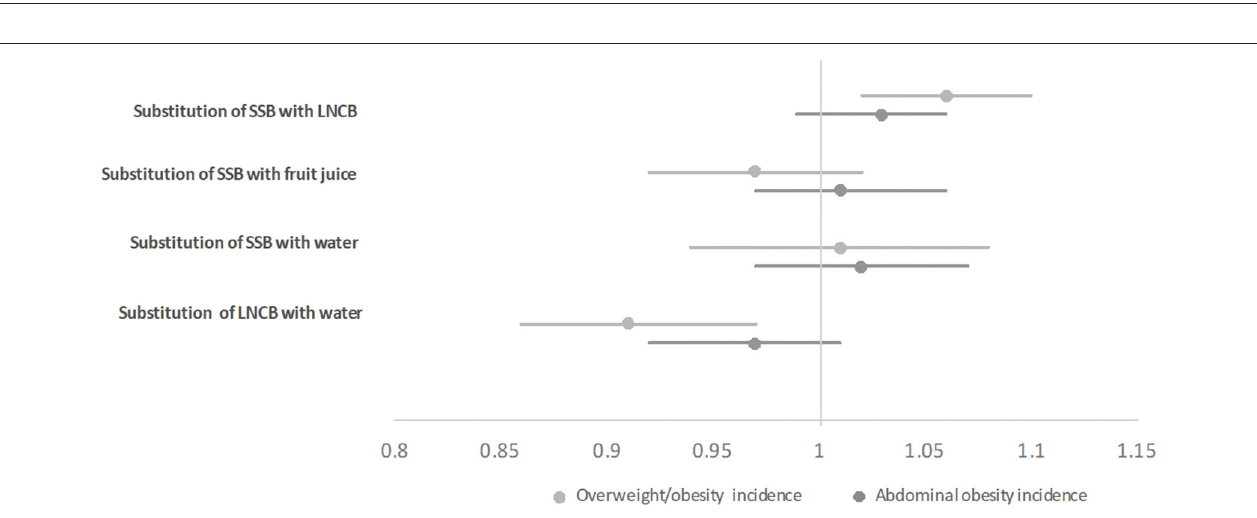
FIGURE 4 | Adjusted substitution associations of one serving of beverage with another with overweight/obesity incidence (IPR, 95%CI) and abdominal obesity incidence (IPR, 95%CI) in participants with normal values at baseline (i.e., < 25 kg/m 2 for overweight/obesity and ≤ 94cm in men and ≤ 80cm in women for abdominal obesity) in the Lifelines Cohort Study; Models were adjusted for age, sex, baseline BMI or baseline waist circumference and height (for models with abdominal obesity as outcome), education, alcohol intake, smoking, physical activity, all dietary factors, and history of diseases; SSB, sugar-sweetened beverages; LNCB, low/no-calorie beverage; IPR, incidence proportion